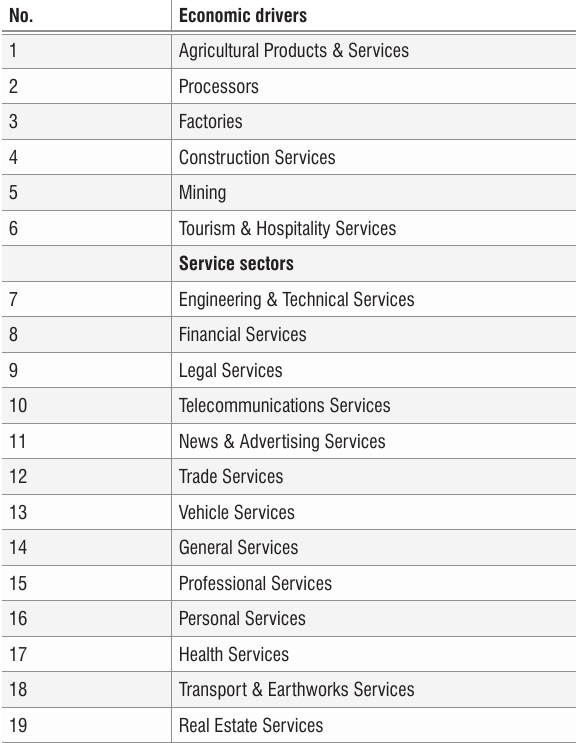
The business sectors used for determining the